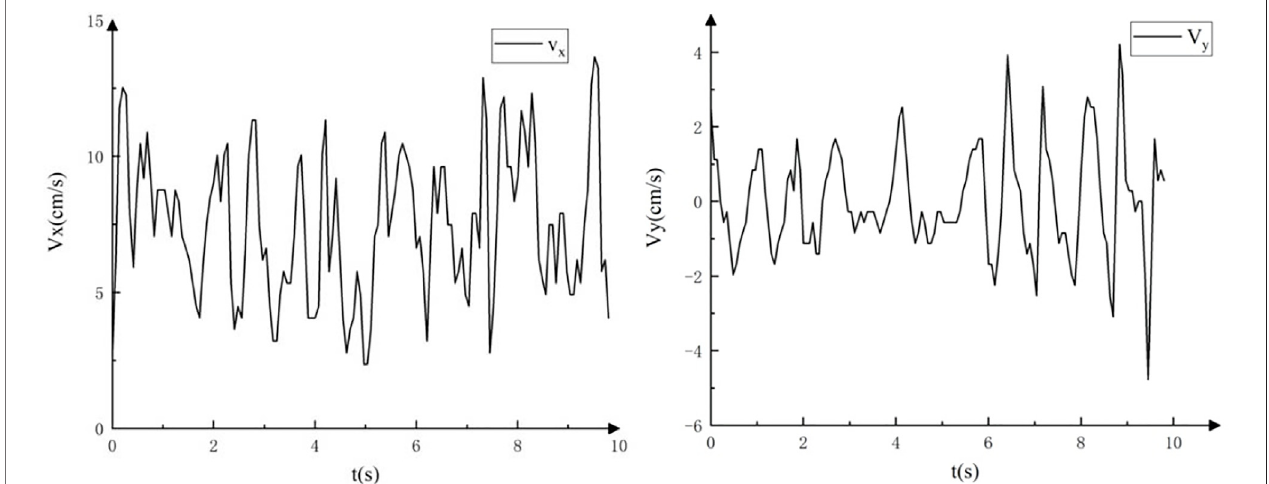
FIGURE 16 | The velocity of the robot in horizontal and vertical directions when straight walking on the underwater fl at ground.